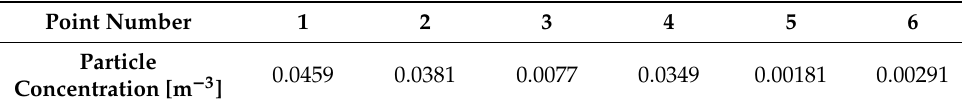
Figure 11. Reference points for the particle concentration as a function of wind direction. Table 6. Particle concentration for Figure 11 reference points.